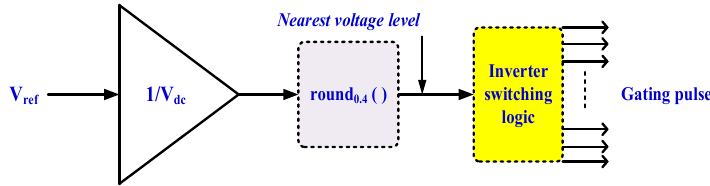
Figure 7. Block diagram of an Optimized Nearest Level Control (ONLC).